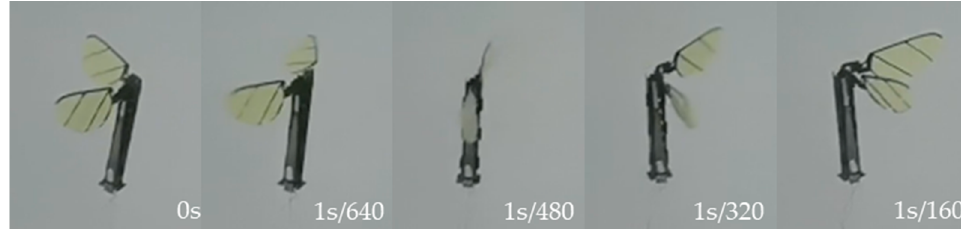
Figure 13. The simultaneous actuation test of both wings.